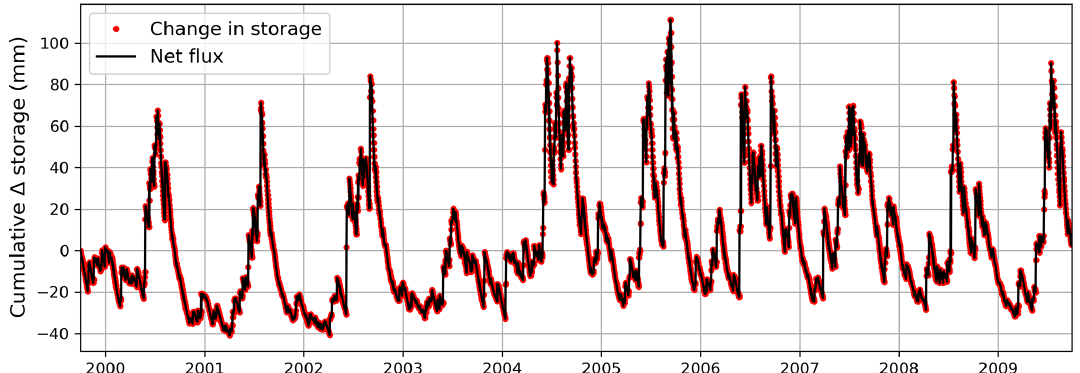
Figure A1. Water balance performance plot for 10-year infiltration experiment, with the best model configuration, showing the cumulative change in storage in the profile and the cumulative inflow minus outflow. The water balance bias was − 0.018mm, and the RMSE of the daily water balance errors was 8.06 × 10 − 5 mm. Table A1. Model performance for the different ODE solvers/methods available in SciPy. ODE solver Method Runtime (s) ode